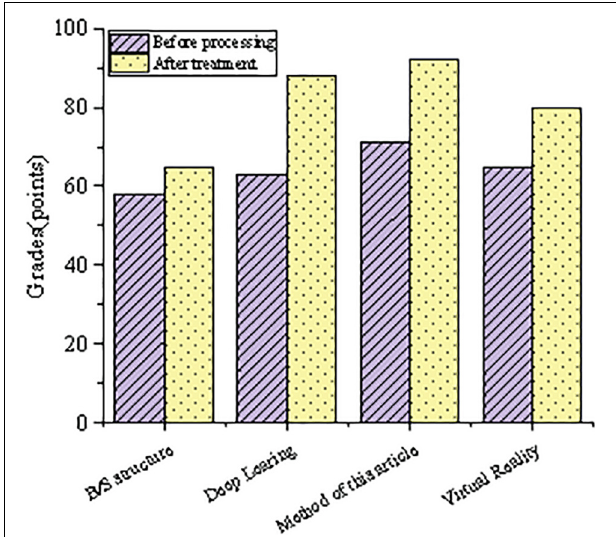
FIGURE 6 | Comparison results of physical exercise effects of different system